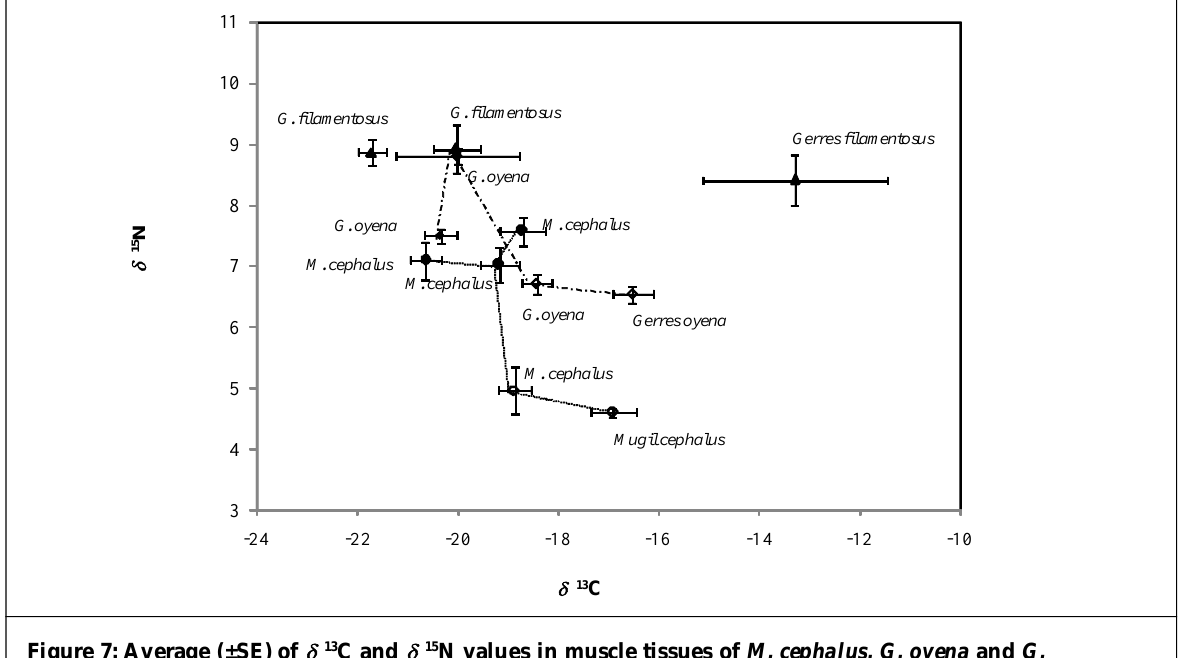
Figure 7: Average (±SE) of  13 C and  15 N values in muscle tissues of M. cephalus, G. oyena and G. filamentosus collected from undisturbed (closed symbols) and disturbed (open symbols) creek sites